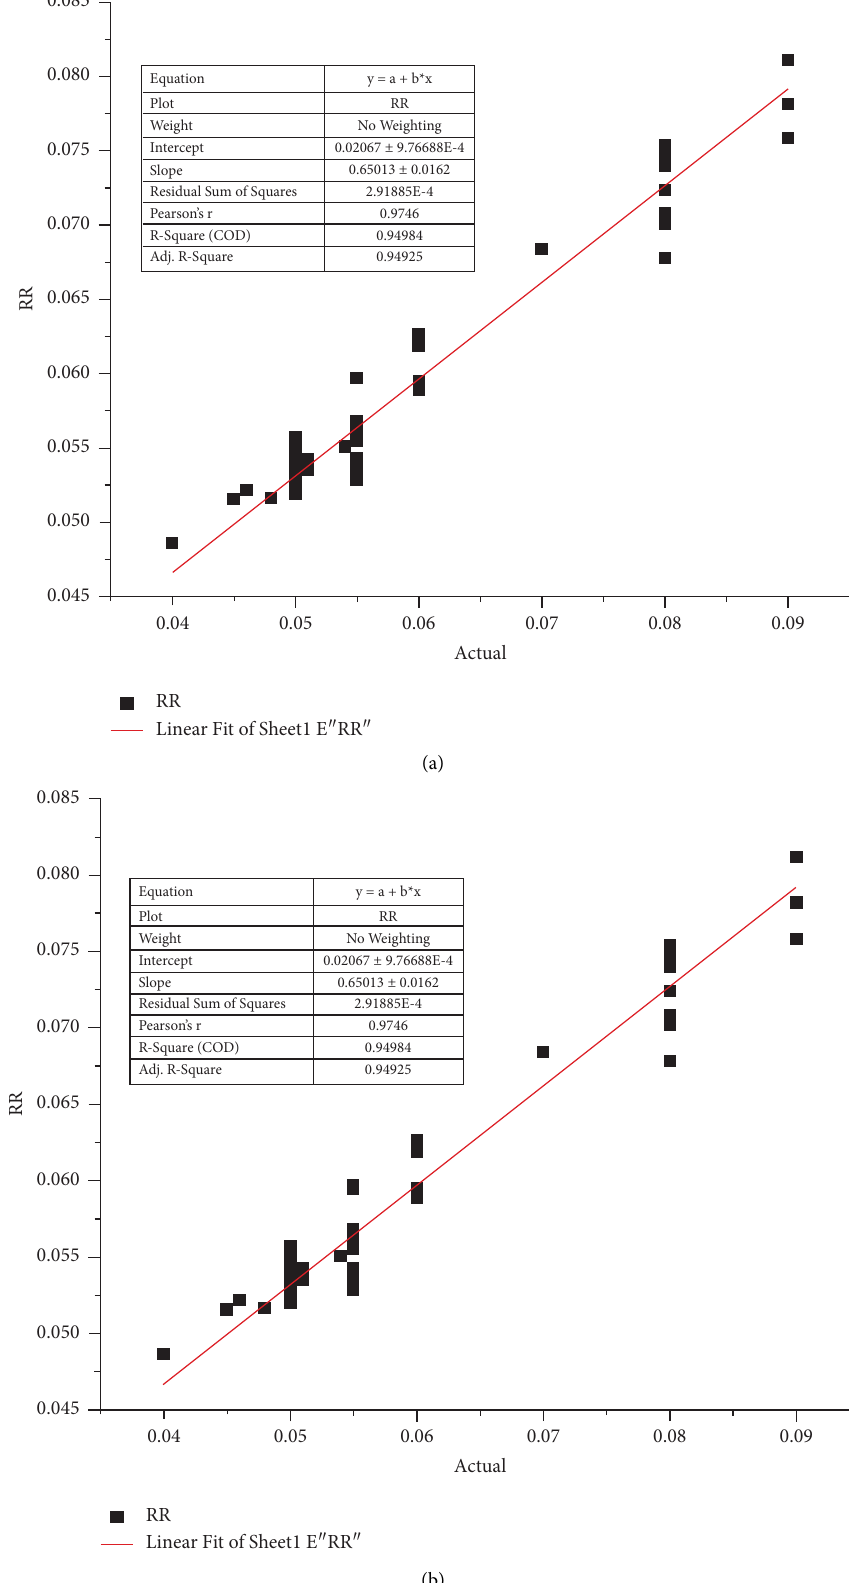
Figure 10: Te Ridge regression model scatter plots for the testing phase of the oil fow: (a) fracture porosity and (b) shape